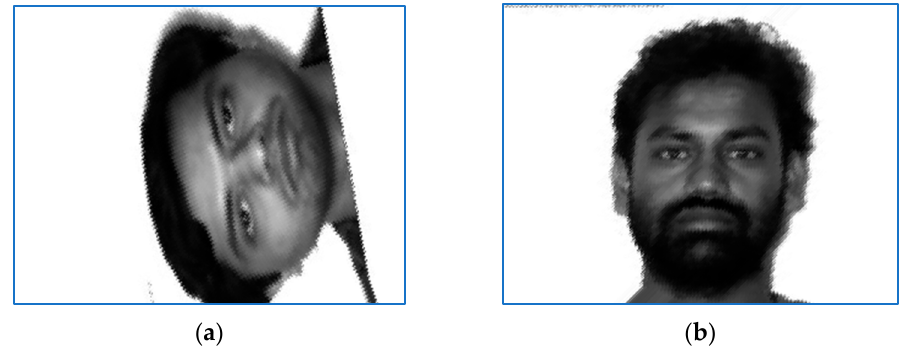
Figure 6. Images registered by PAT: ( a ) subject 10; ( b ) subject 7.